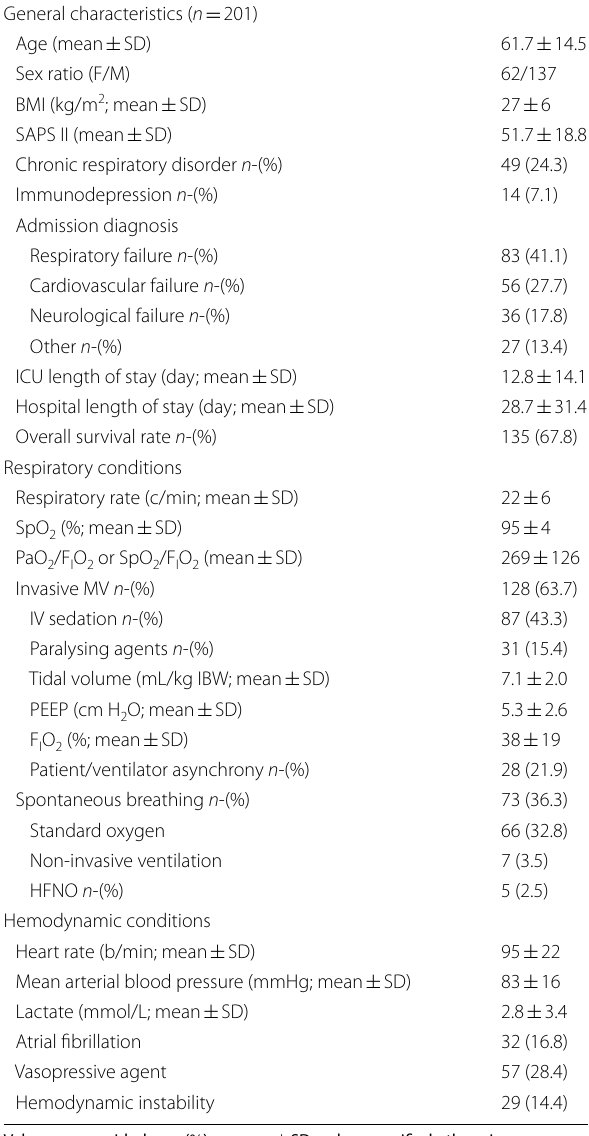
Table 1 Physiological characteristics of the patients— retrospective